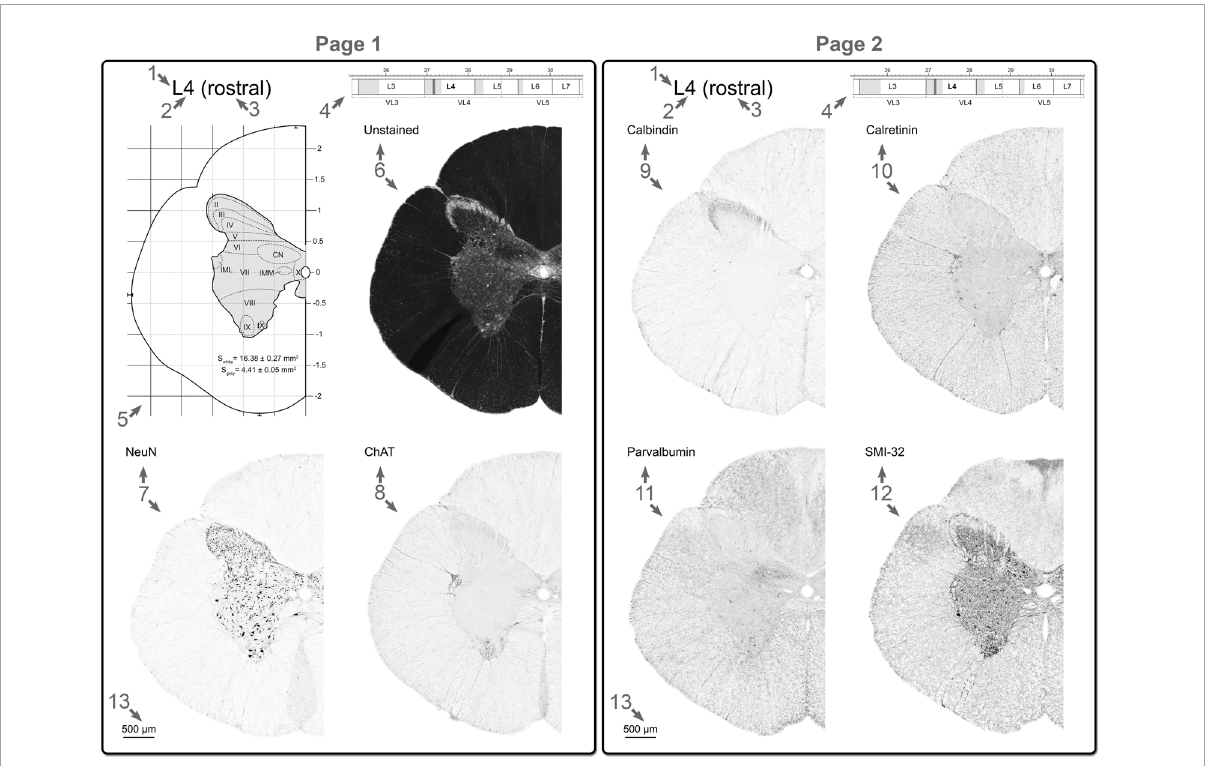
FIGURE3 Example of the atlas pages for one region of interest of the one spinal segment: (1) the spinal cord region (C, cervical; T, thoracic; L, lumbar; S, sacral; Co, coccygeal); (2) the serial number of the segment; (3) the part of the segment (rostral, middle, caudal); (4) part of the scheme of the spatial interrelation between the segment and vertebra, region of interest is shown as the vertical grid; (5) stereotaxic grid and a schematic representation of the transverse slice with laminar and nuclear borders; (6) unstained slice; (7) NeuN stained slice; (8) ChAT stained slice; (9) calbindin stained slice; (10) calretinin stained slice; (11) parvalbumin stained slice; (12) SMI-32 stained slice; (13) Scale bar. See details in Section “Creation of the atlas